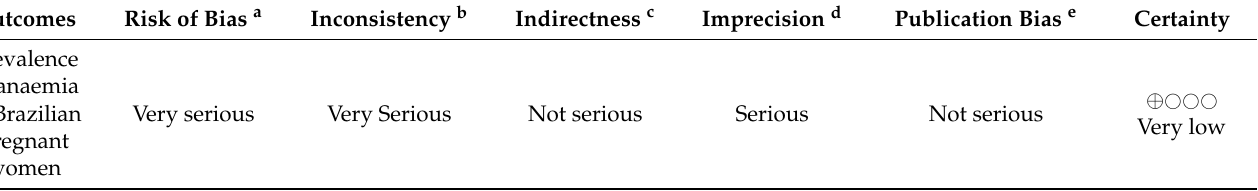
Table 3. GRADE evidence profile for prevalence of anaemia in Brazilian pregnant